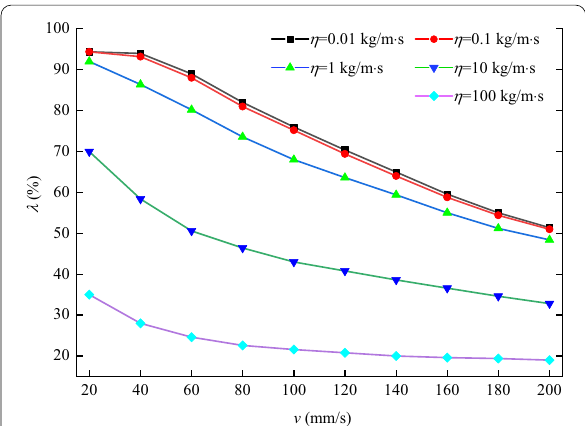
Figure 9 The influence curve of the drainage area rate on the coring rate